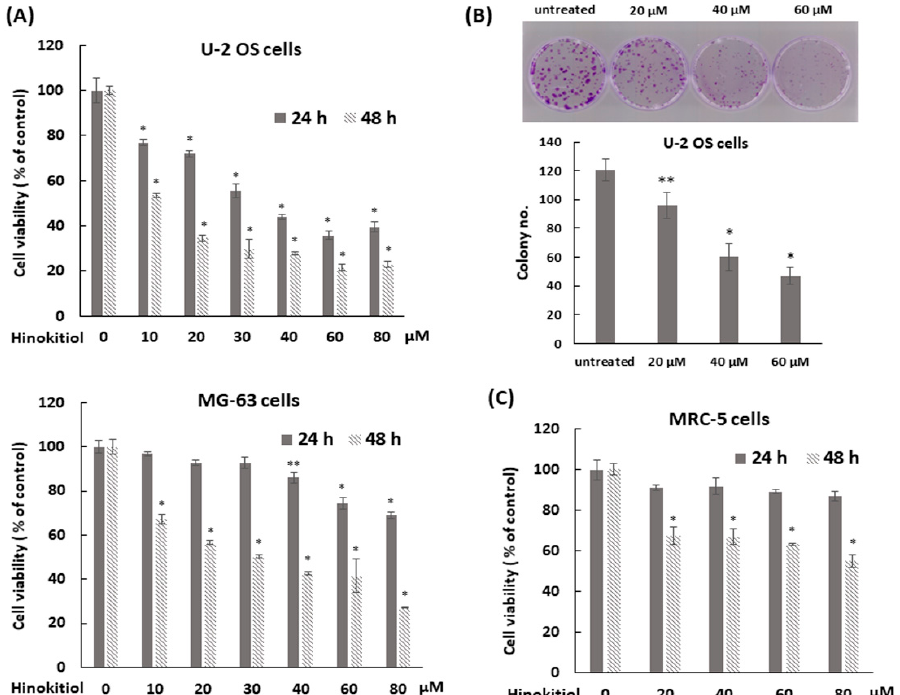
Figure 1. Hinokitiol suppresses cell viability of human osteosarcoma cell lines. ( A ) Hinokitiol inhibits cell growth of osteosarcoma U-2 OS and MG-63 cell lines. U-2 OS or MG-63 cells were incubated with different dose of hinokitiol for 24 or 48 h. MTT assays were performed to measure cell viability. ( B ) Hinokitiol inhibits colony formation of osteosarcoma cell line. After administration of hinokitiol for 6 h, U-2 OS cells were washed by PBS, trypsinized, and then five thousand cells were cultured onto 35 mm dishes with drug-free complete medium for 10 days to allow colony formation. Colonies were stained by 1% crystal violet solution before counting. Quantitative data of colony number/dish were estimated as below. Data are expressed as mean ± SD of three independent experiments. ( C ) The effect of hinokitiol on human lung fibroblast MRC-5 cells. MRC-5 cells were incubated with different doses of hinokitiol for 24 or 48 h. MTT assays were performed to measure cell viability. * p < 0.001, and ** p = 0.001.